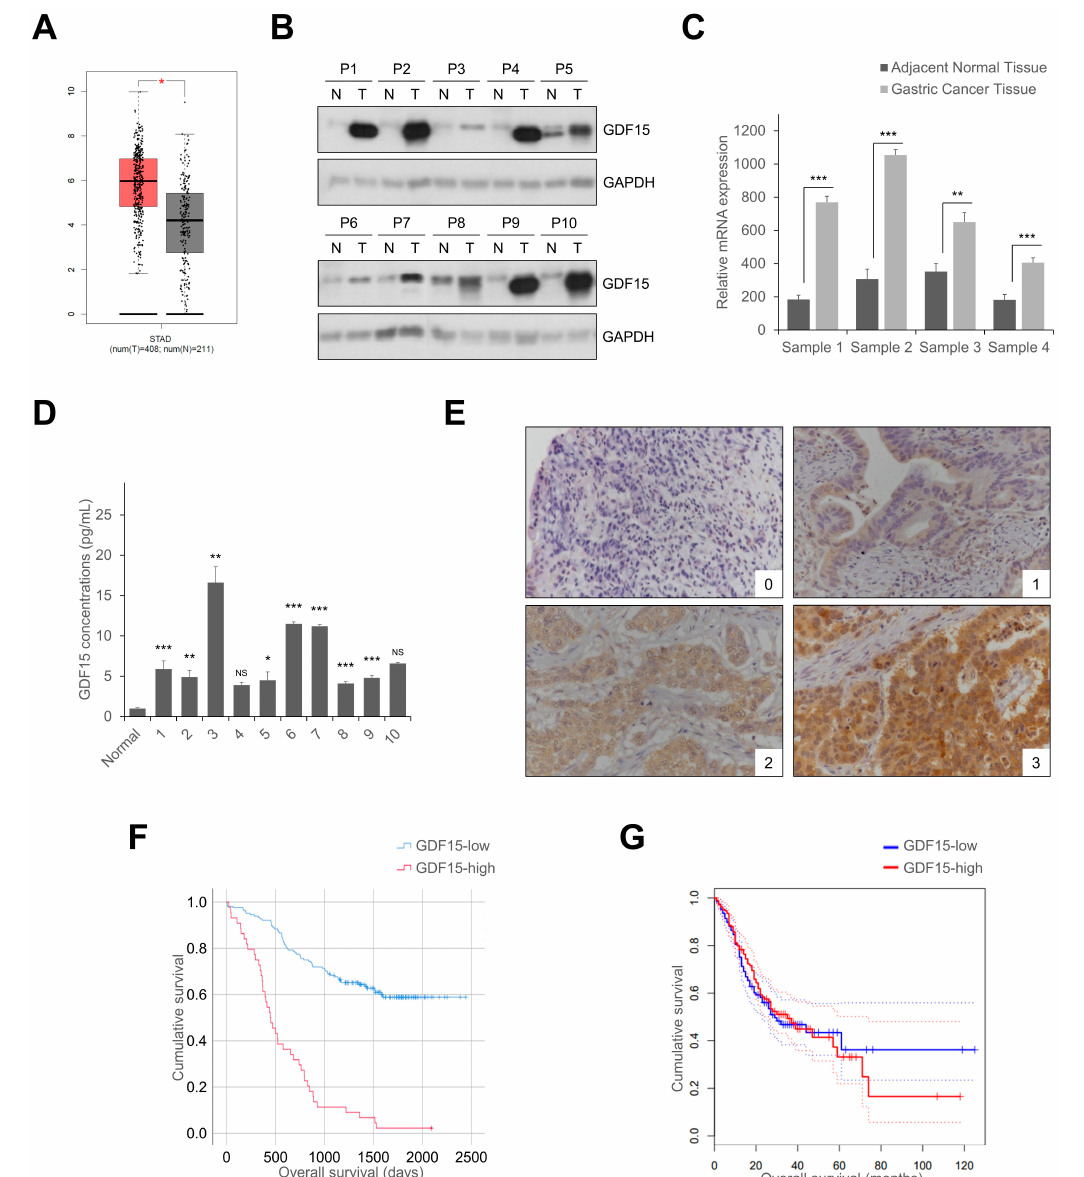
Figure 1. GDF15 expression in human gastric normal tissue and gastric cancer tissue and serum. ( A ) GDF15 is highly expressed in gastric cancer tumors compared to gastric normal in the GEPIA database. ( B ) Western blotting analysis of GDF15 expression levels in adjacent normal tissues and gastric cancer tissues from CNUH patients. ( C ) The mRNA expression level of GDF15 in adjacent normal tissue and gastric cancer tissues was determined by RT-qPCR. The data are presented as the means ± SD and were evaluated using Student’s t -test ( n = 3). ( D ) Gastric cancer serum and normal serum were subjected to ELISA for measurement of the GDF15 level. The data are presented as the means ± SD and were evaluated using Student’s t -test ( n = 3). ( E ) Expression of GDF15 protein in gastric cancer tissues. Gastric cancer tissues were immunohistochemically stained with an anti-GDF15 antibody. Magnification: × 100. 0, no staining; 1, weak staining; 2, intermediate staining; 3, strong staining. ( F , G ) Kaplan–Meier survival analysis revealed that overall survival is poorer in gastric cancer patients with a high expression of GDF15 among the CNUH and GEPIA datasets. NS, not significant. * p < 0.05, ** p < 0.01, and *** p <